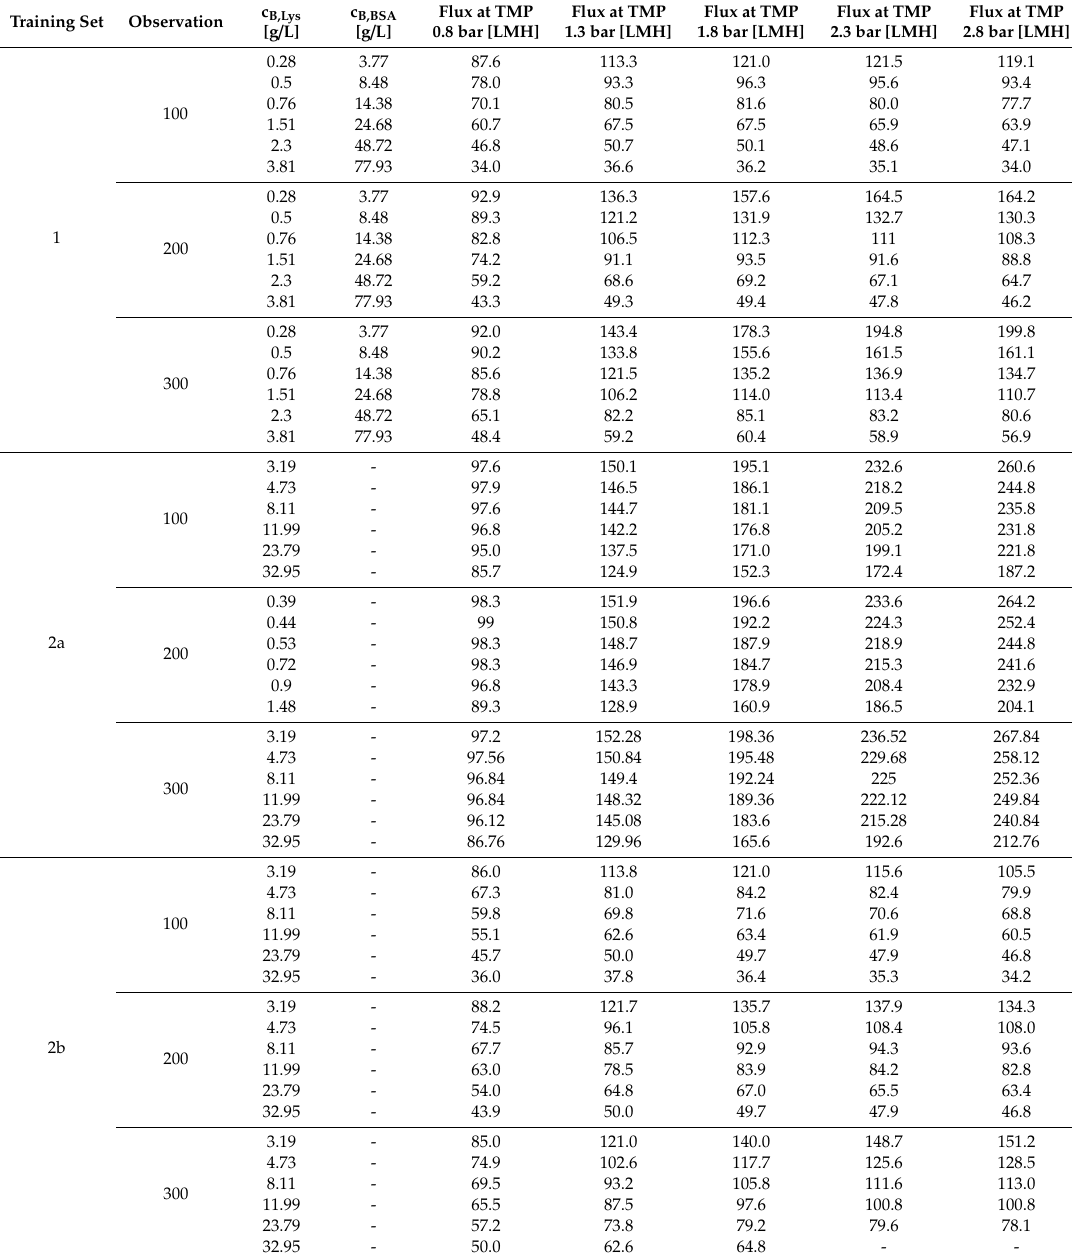
Table A1. Summary of all training data including measured c B,BSA , c B,Lys, and observed